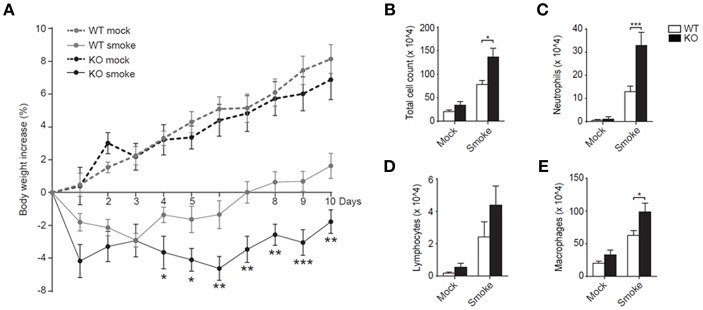
LAIR-1 regulates neutrophilic airway inflammation during cigarette-smoke exposure. (A–E) Mice were exposed to cigarette smoke or mock (air) in whole-body chambers twice daily for 10 consecutive days. (A) Body weight of mice was measured daily and percentage change relative to day 0 was calculated. Total (B) and differential counts (C–E) in BAL were determined after 10 days of cigarette-smoke exposure. Data are representative of at least 10 mice per group in 2 independent experiments. *p < 0.05, **p < 0.01, ***p < 0.001. The Mann-Whitney U test was used to calculate the statistical significance of differences between WT and KO mice (A) and a 2-way ANOVA with Holm-Šídák multiple comparison correction was used for the cell counts (B,C). WT, wild-type and KO, Lair1−/− on C57BL/6 background.